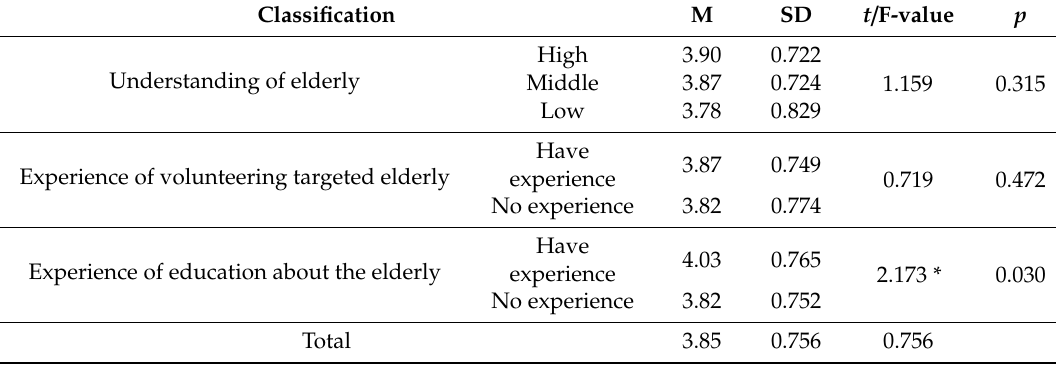
Table 4. Di ff erence in need for an occupation group for senior beauty